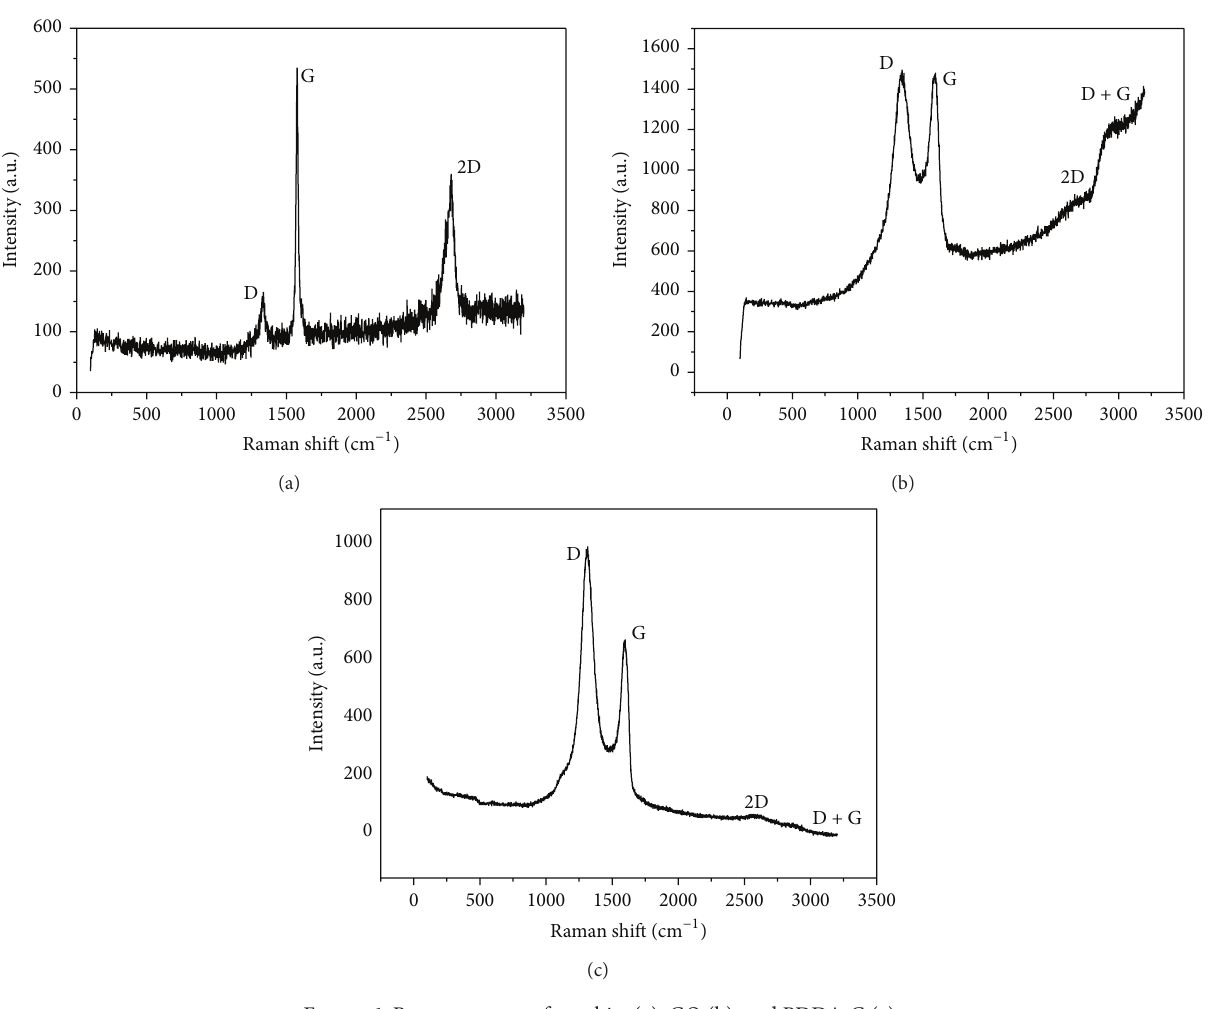
Figure 1: Raman spectra of graphite (a), GO (b), and PDDA-G